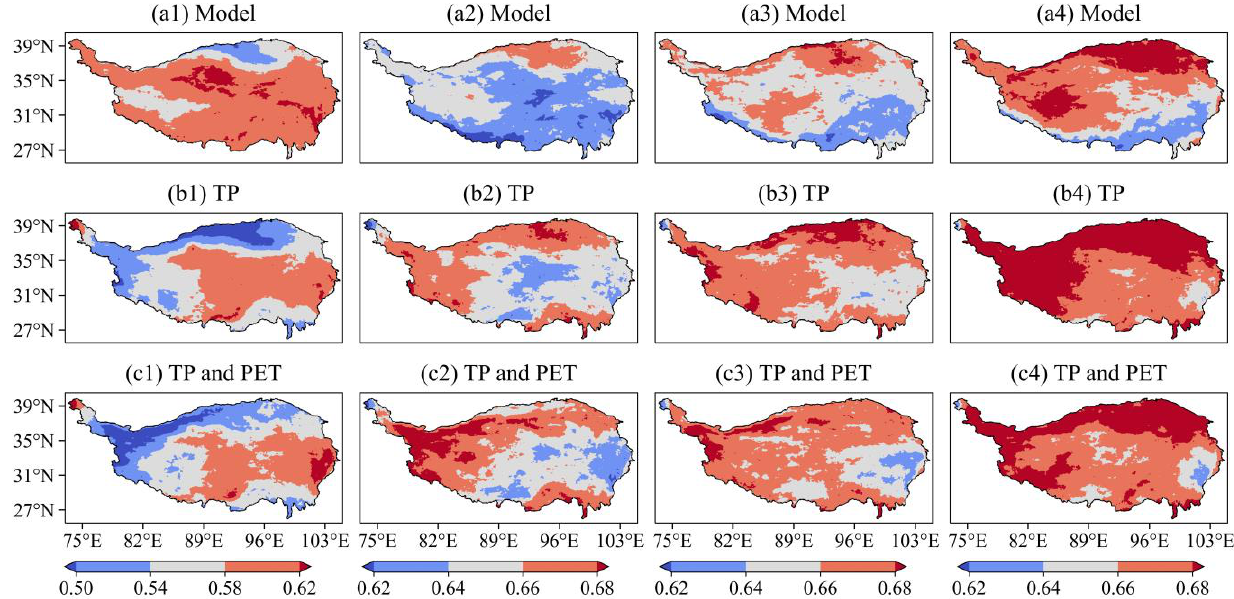
Figure 8. Spatial distribution of drought intensity feature. ( a – c ) are, respectively, intensity (uncor- rected) intensity (only TP corrected), and intensity (TP and PET corrected). ( a1 – a4 ) are historical, SSP1-2.6, SSP2-4.5, and SSP5-8.5 scenarios, respectively.